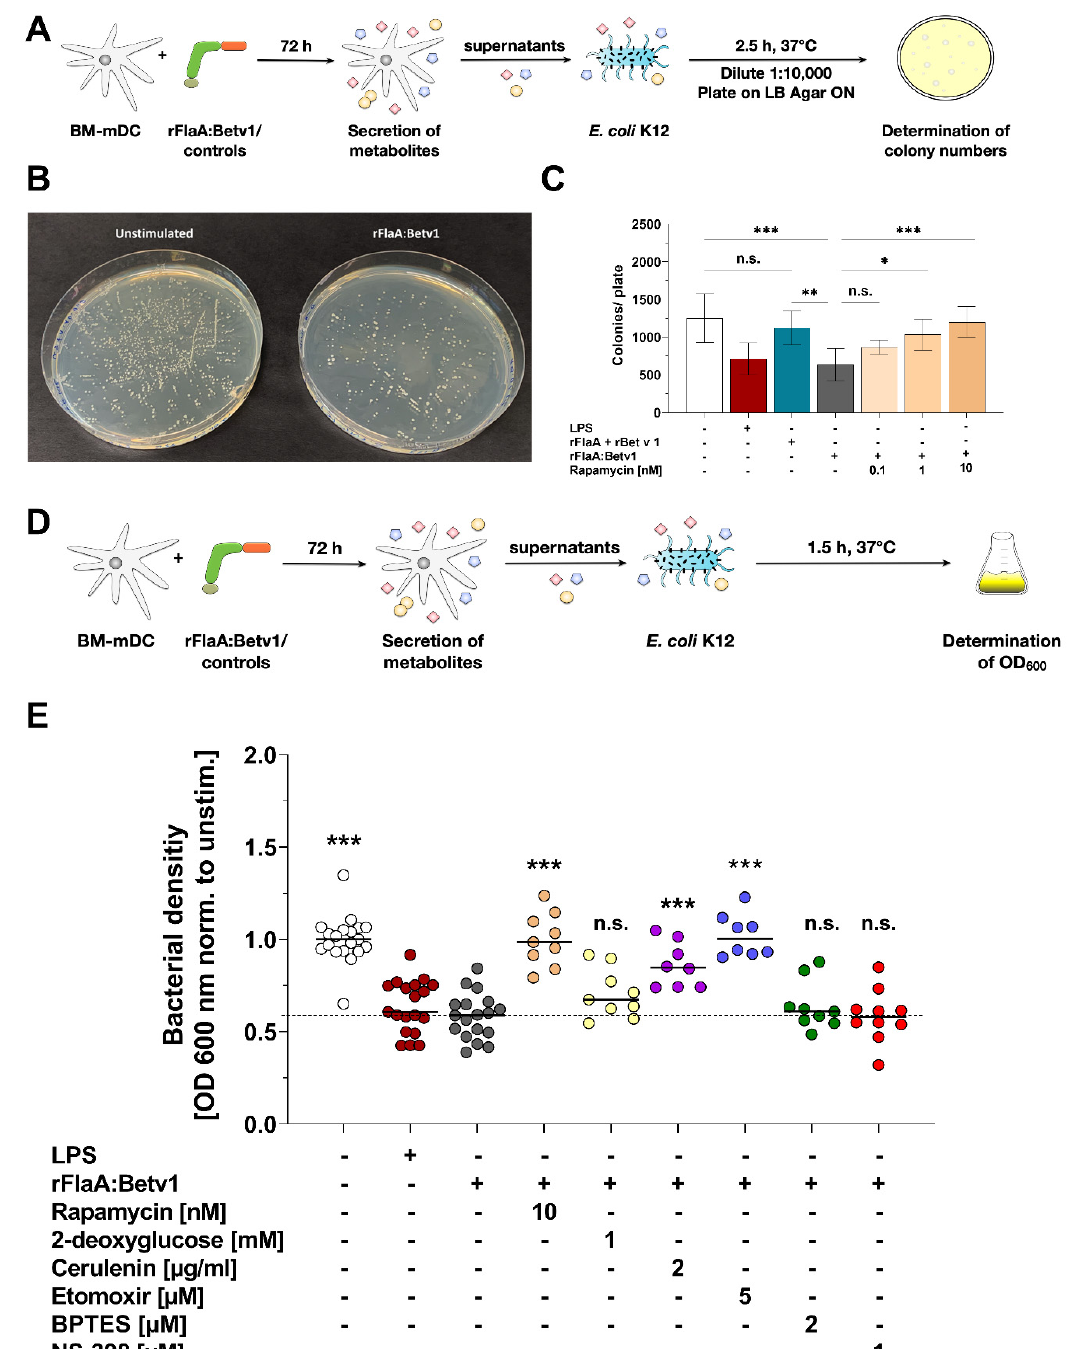
Figure 4. rFlaA:Betv1 triggers a mTOR- and fatty acid metabolism-dependent secretion of antimicrobial factors from stimulated mDCs. E. coli K12 cultures were incubated for 2.5 h with supernatants derived from mDCs stimulated as indicated and plated overnight on agar plates ( A ). Bacterial growth was documented photographically ( B ) and colony numbers were counted manually ( C ). Bacterial growth in liquid cultures was determined photometrically by measuring the OD 600nm 1.5 h post-addition of the indicated supernatants ( D , E ). Data are either representative results of four independent experiments that showed similar results ( B ) or results of three to four independent experiments ( C , E ). Statistical comparisons were performed by 2-way ANOVA with correction for multiple comparisons according to Turkey and indicated as: n.s. p -value > 0.05, * p -value < 0.05, ** p -value < 0.01, or *** p -value <